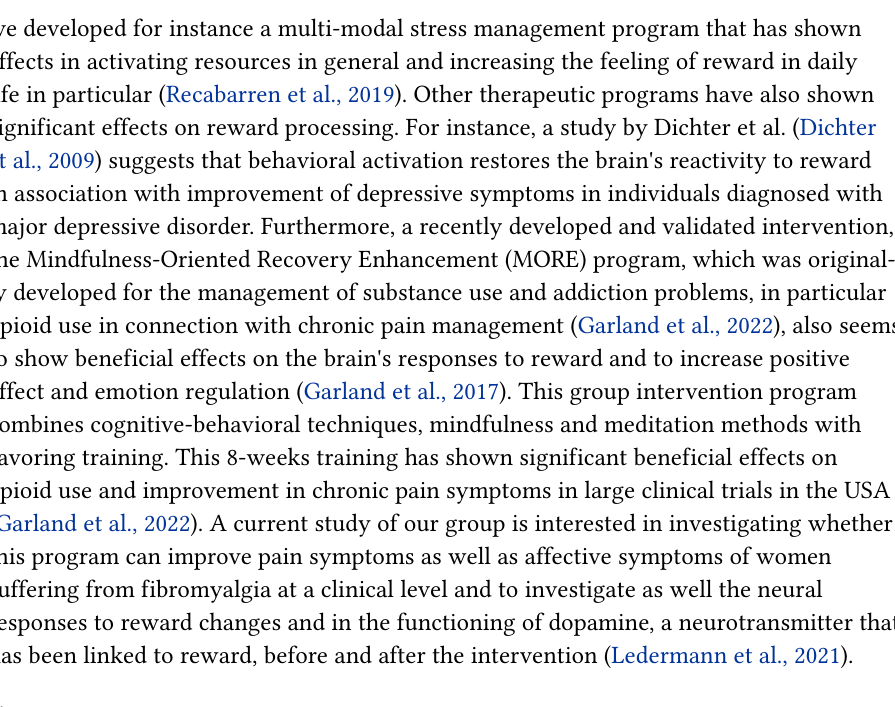
Simplified Schematic Model of the Stress-Reward Interaction as Mediator of the Relationship Between Stress Exposure and the Development of Psychopathological Symptoms